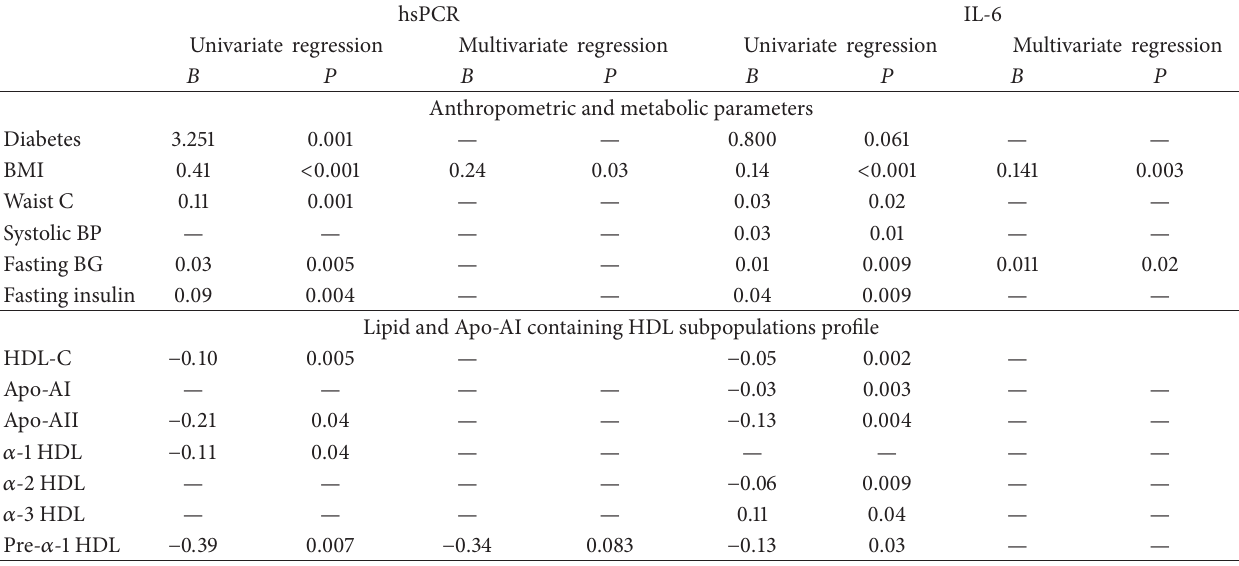
Table 3: Univariate and multivariate regression analysis between hsCRP and IL-6 and metabolic, lipid, and Apo-AI containing HDL subpopulations profile in total